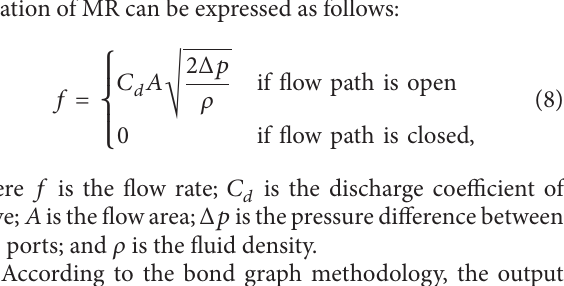
Figure 6: Bond graph model of the